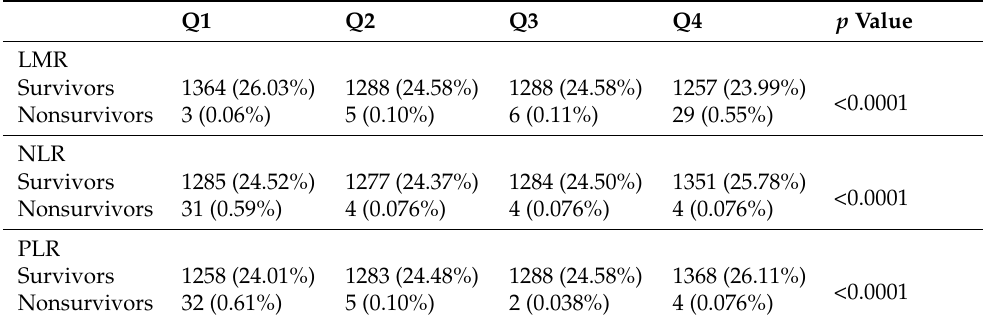
Table 3. The relationship between LMR, NLR and PLR with hospital